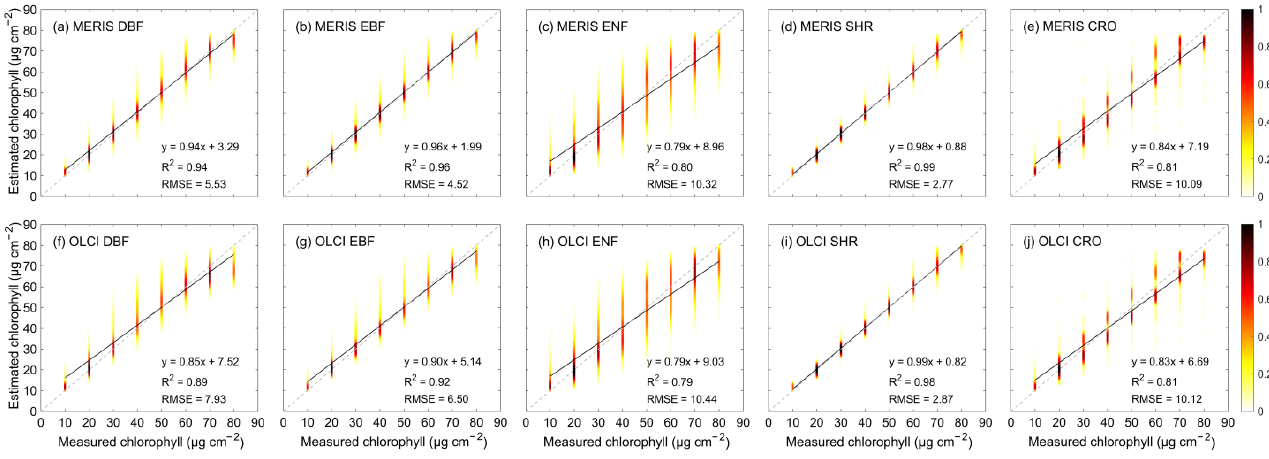
Figure 4. Performances of LCC inversion with the synthetic dataset using the LUT algorithms. ( a – e ) represent the performances on the MERIS synthetic dataset; ( f – j ) represent the performances on the OLCI synthetic dataset. Darker colors indicate higher dot density.